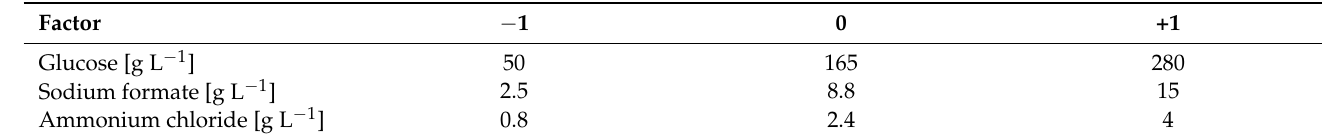
Table 4. Factor levels for CCD during this